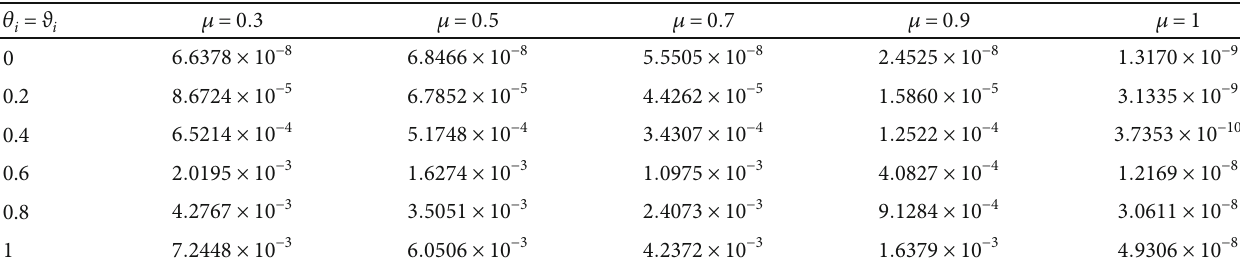
Table 3: Absolute errors for k